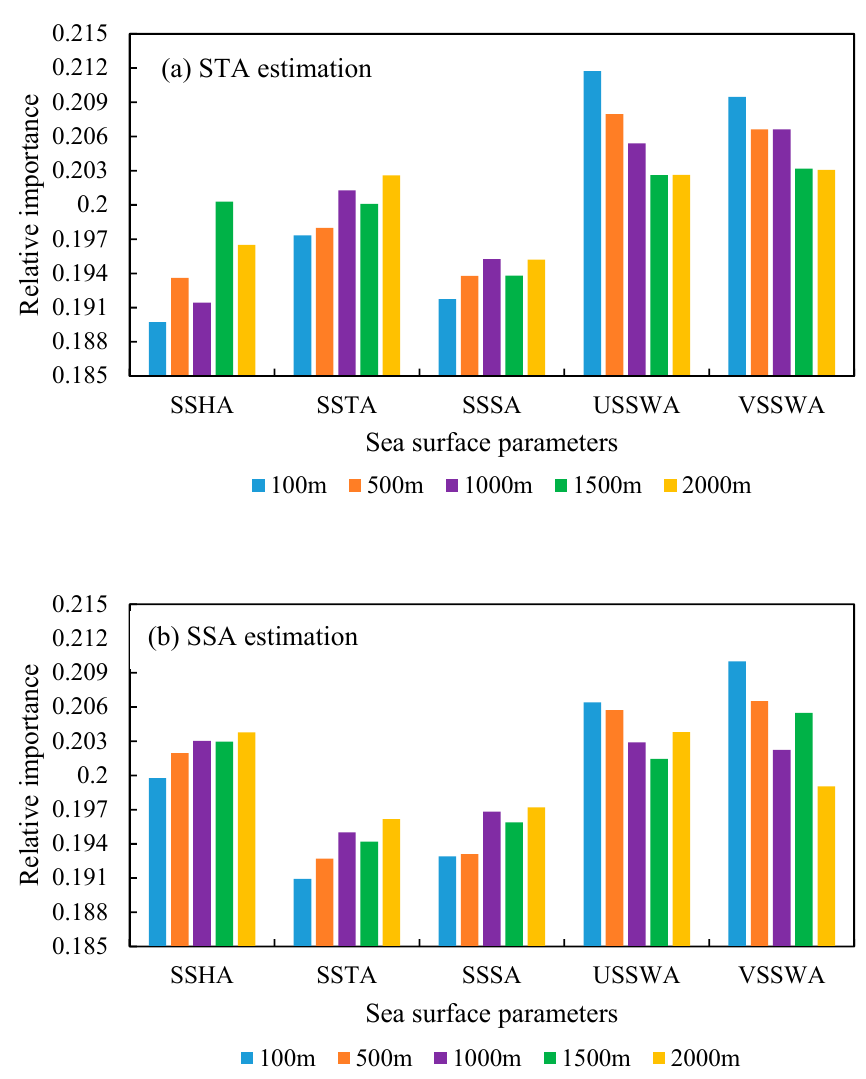
Figure 11. The relative importance of the five sea surface parameters (SSHA, SSTA, SSSA, USSWA, and VSSWA) for the XGBoost ( a ) STA and ( b ) SSA estimation model at 100 m (blue), 500 m (orange), 1000 m (purple), 1500 m (green), and 2000 m (yellow) in January.